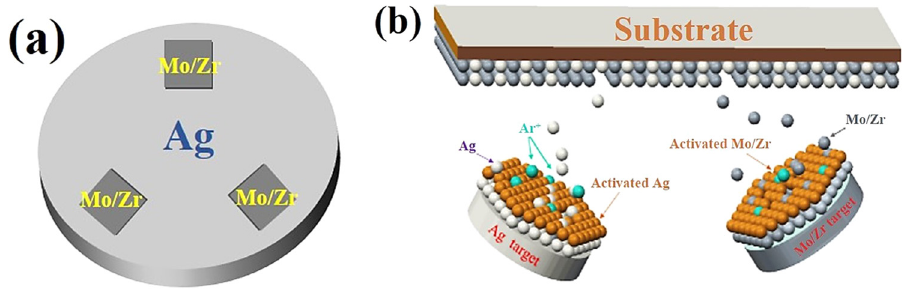
Figure 1: The schematic diagram of sputtering targets: ( a ) composite target sputtering and ( b ) co -